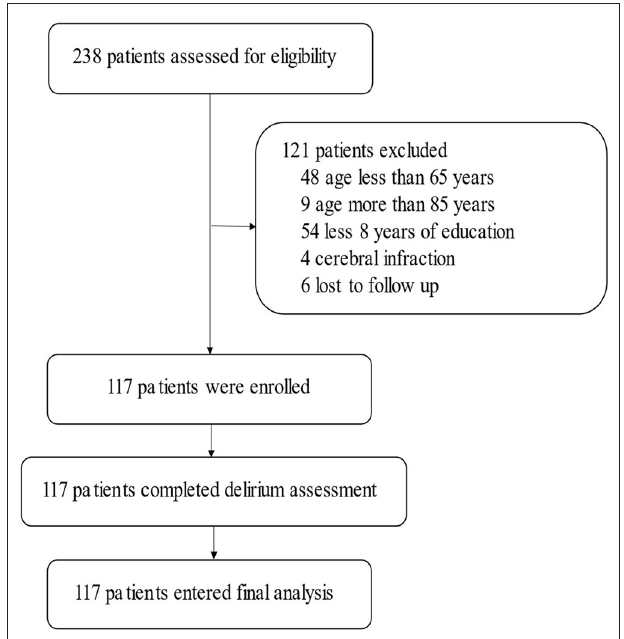
FIGURE 1 | Flow chart of the